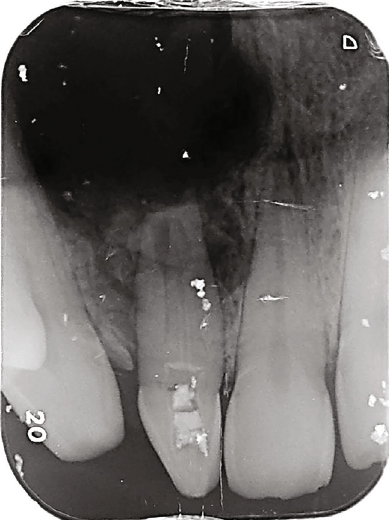
Figure 3: Preoperative radiograph showing a complex root canal con fi guration corresponding to that of type II DI associated with a large extending periapical image in relation to tooth